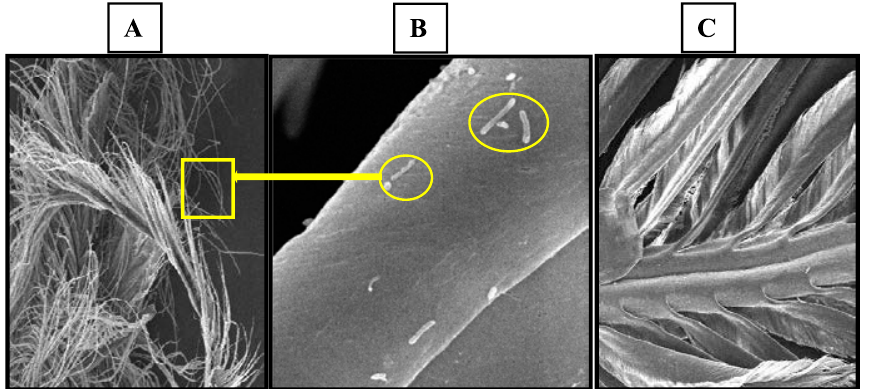
Fig. 1. SEM images (Magnification at 1000×) of feather degradation by A. chrocoocum B4. (A) Barbules and barbs degradation after 5 days; (B) Colonization of Azotobacter chrocoocum B4 on feather surface in 5 d (yellow circles); (C) Whole chicken feather and feather barbs being